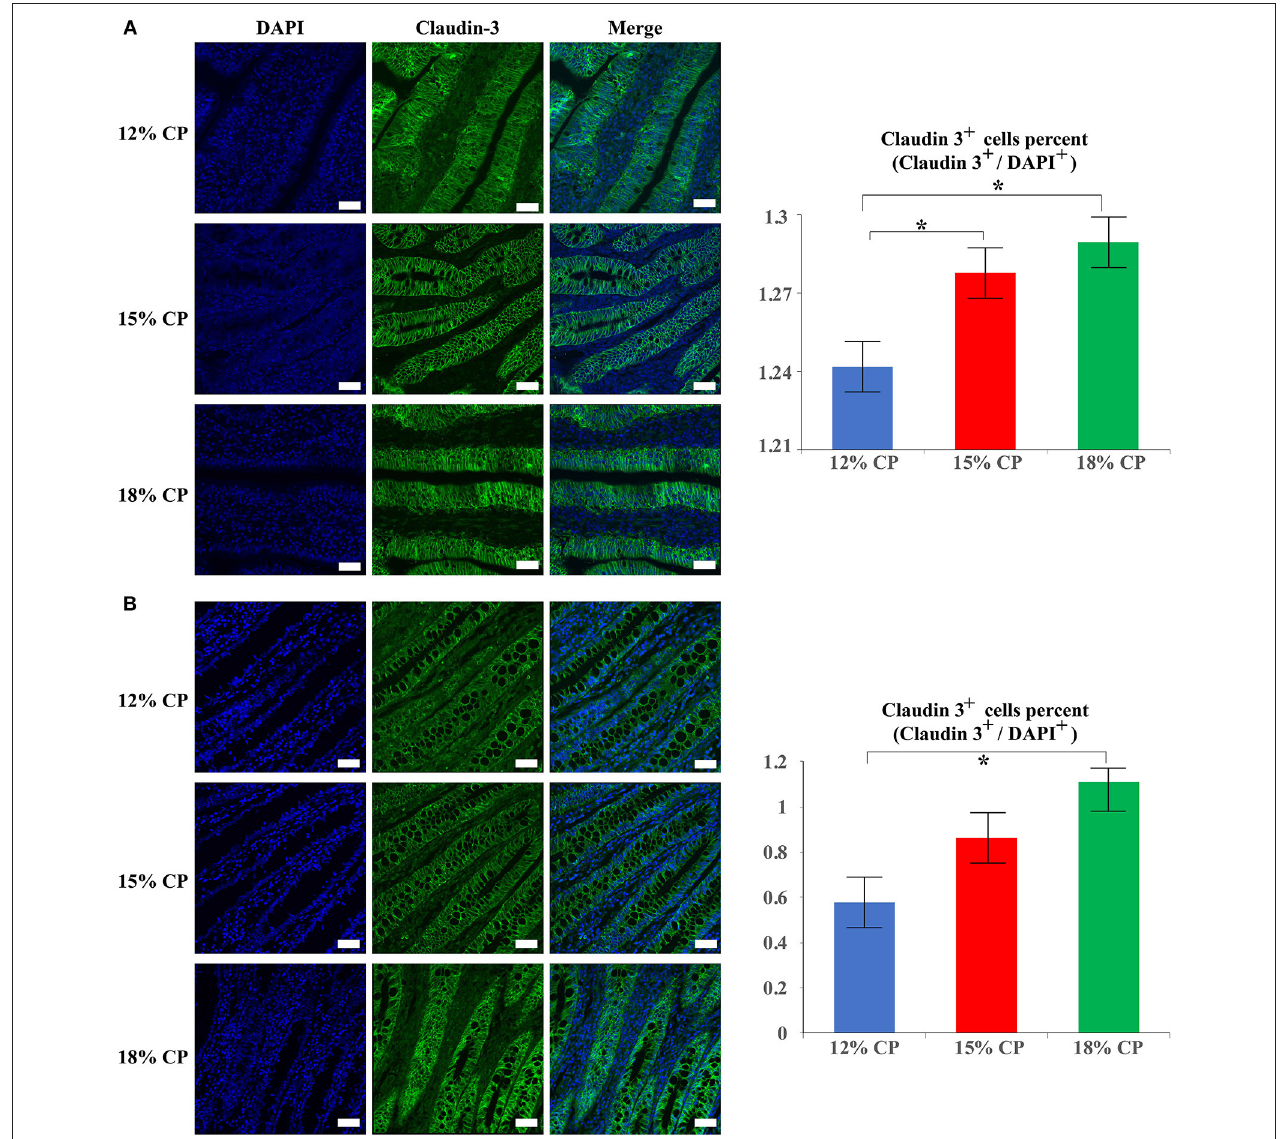
FIGURE 7 | Effects of low-protein diets on staining of claudin-3 in the ileum and colon in growing pigs. (A) Distribution and intensity of claudin-3 staining in ileal tissue. (B) Distribution and intensity claudin-3 in colonic tissue. Values are means ± standard deviations ( n = 3). Scale bar: 20 µ m. Star indicates a significant difference ( P <